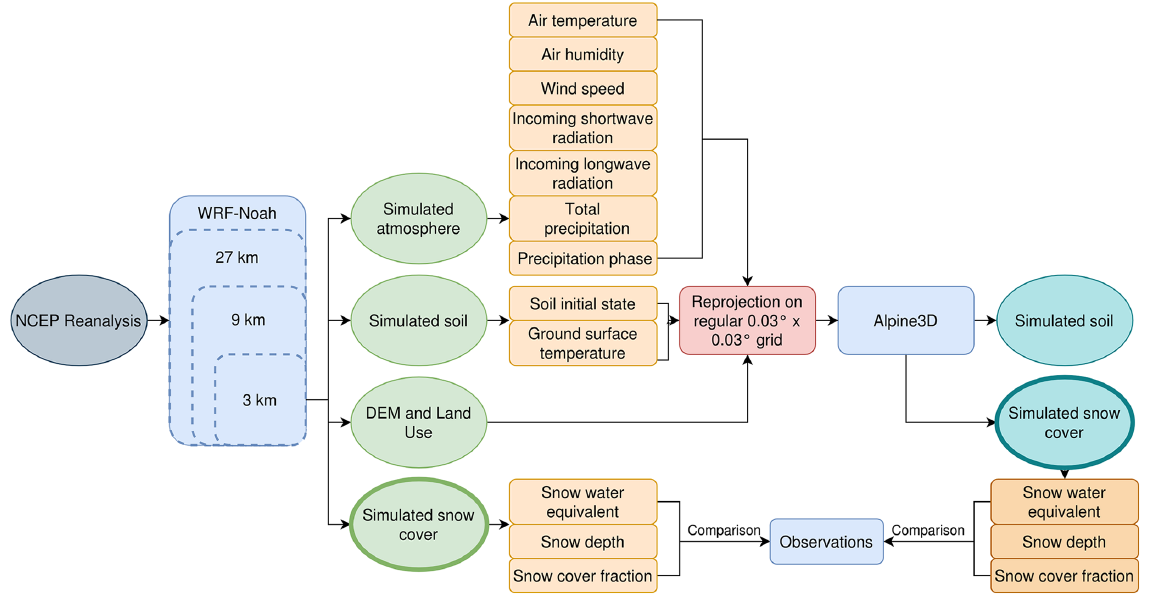
Figure 2. Flowchart of the model chain realized in this study. NCEP reanalyses are used to initialize the WRF model, which provides the atmospheric forcing data to drive WRF–Noah (online-coupled) and WRF–Alpine3D (offline-coupled) numerical